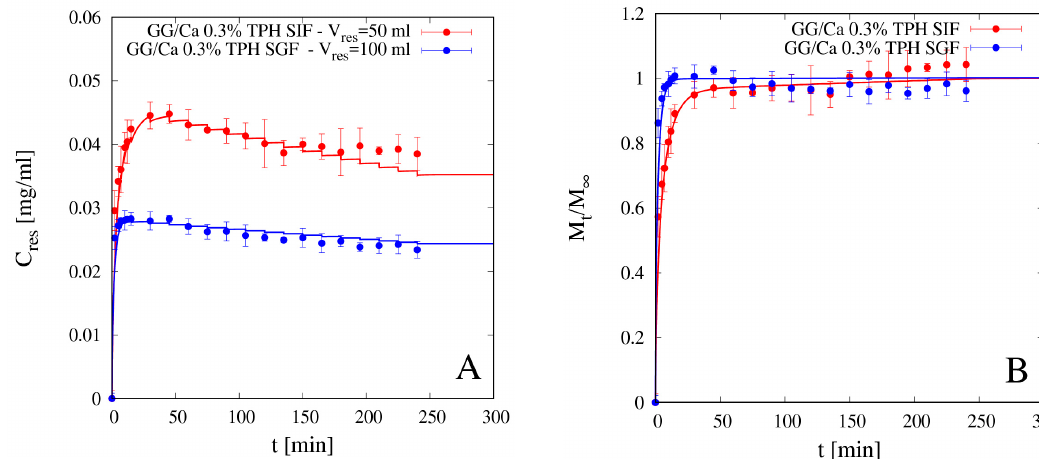
Figure 9. Differential ( A ) and integral release curves ( B ) for theophylline (TPH) from beads GG/Ca 0.3% w/w without laponite in SGF and SIF. Continuous lines represent model predictions Equations (11)–(13). Estimated values of the TPH effective diffusivity D dsg are reported in Table 4.